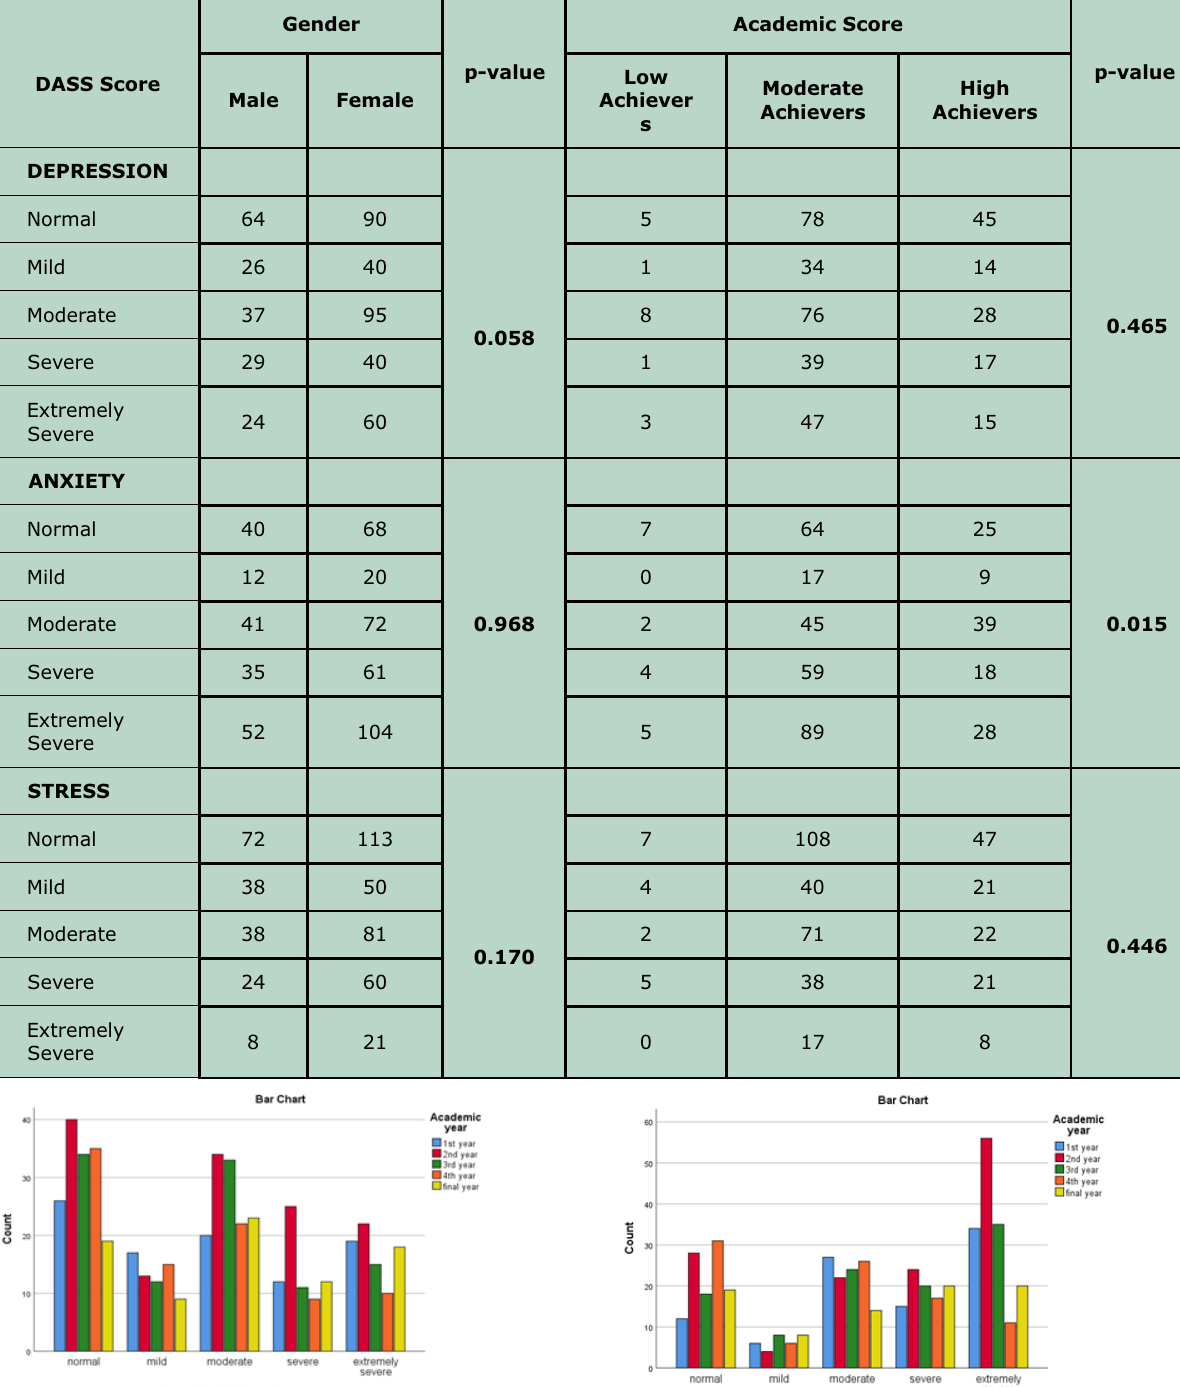
Table-I: Association of DASS score with gender and academic score.